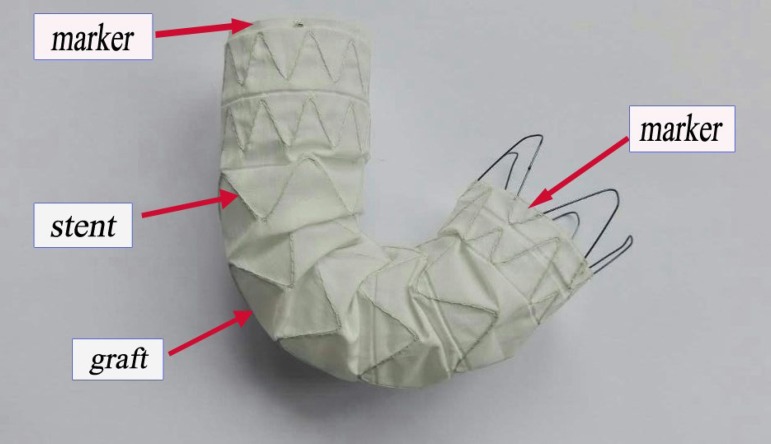
Stent-graft system